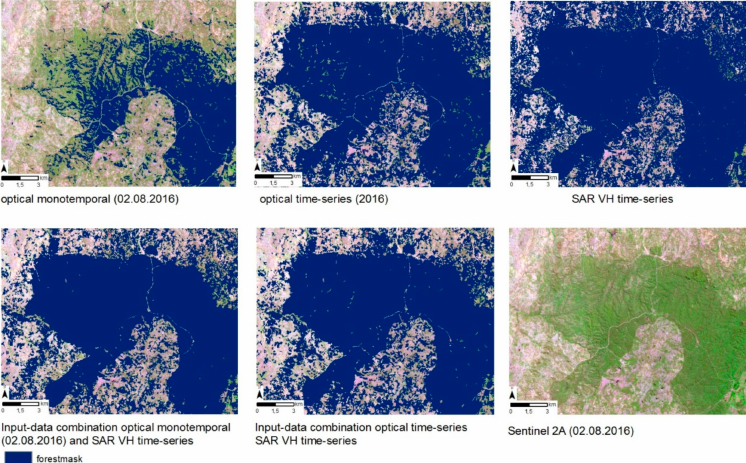
Figure 4. Visualization of forest maps from different input data sets and data-based combination for a subset in